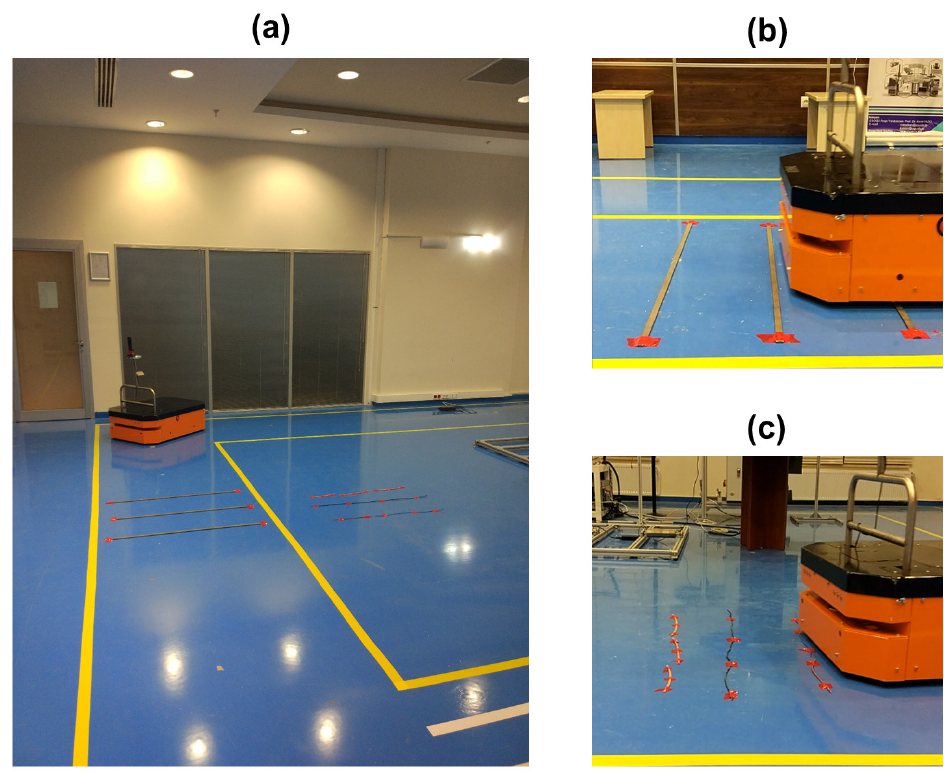
Figure 4. Testing environment and real-time inference: ( a ) testing environment; ( b ) obstacles for high-level anomaly, and ( c ) obstacles for low-level anomaly.